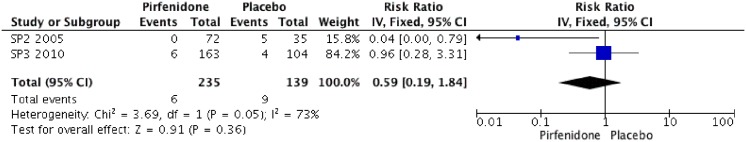
Comparison 4.Acute exacerbation.